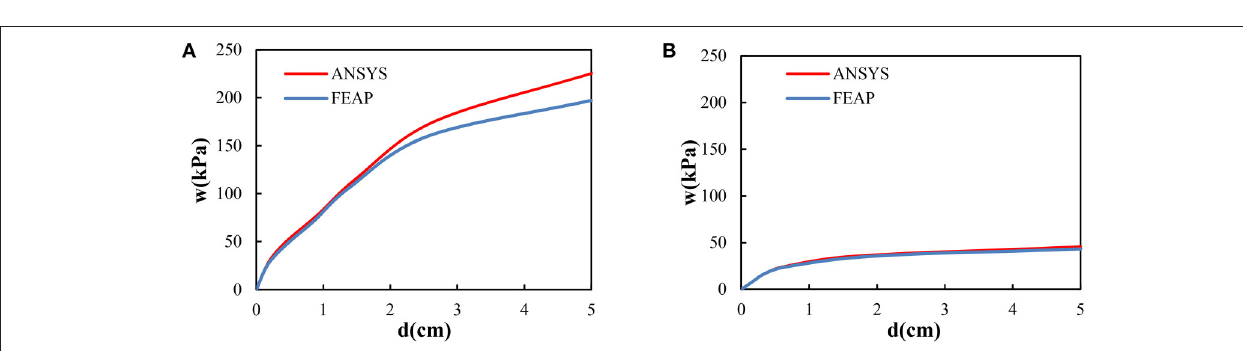
4 m: (A) clamped and (B) simple supported. =